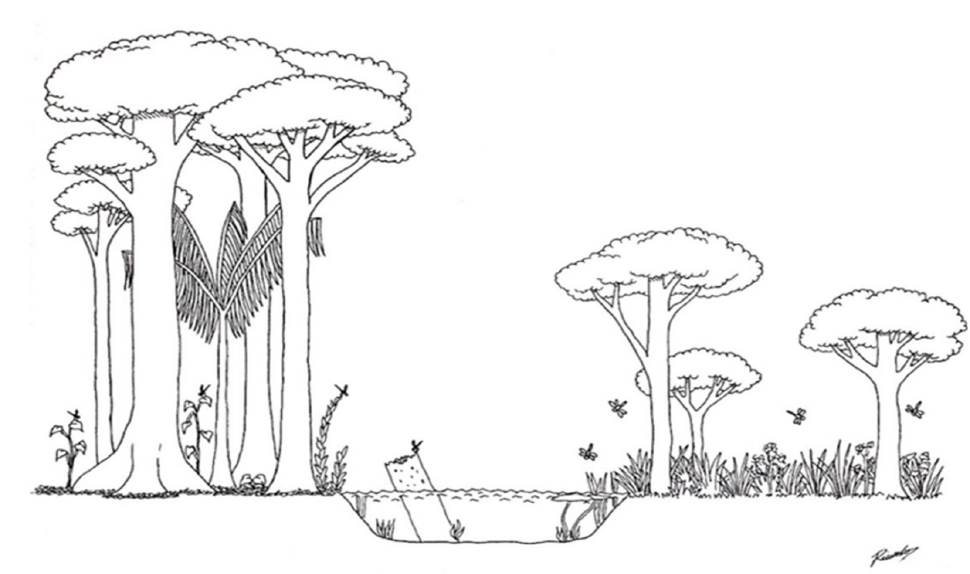
Figure 4. A hypothetical summary describing the physical structure of the streams sampled in the study, according to variables selected by the PCA axes. The left bank of the stream represents a structured forest environment, with the presence of a closed canopy formed by the canopies of large trees, which act as permanent sources of wood (perch or oviposition point) inside and outside the channel. The right side of the stream represents an environment altered for anthropogenic uses, with few and sparse large trees and a predominance of shrubs and grasses, allowing the entry of more light and